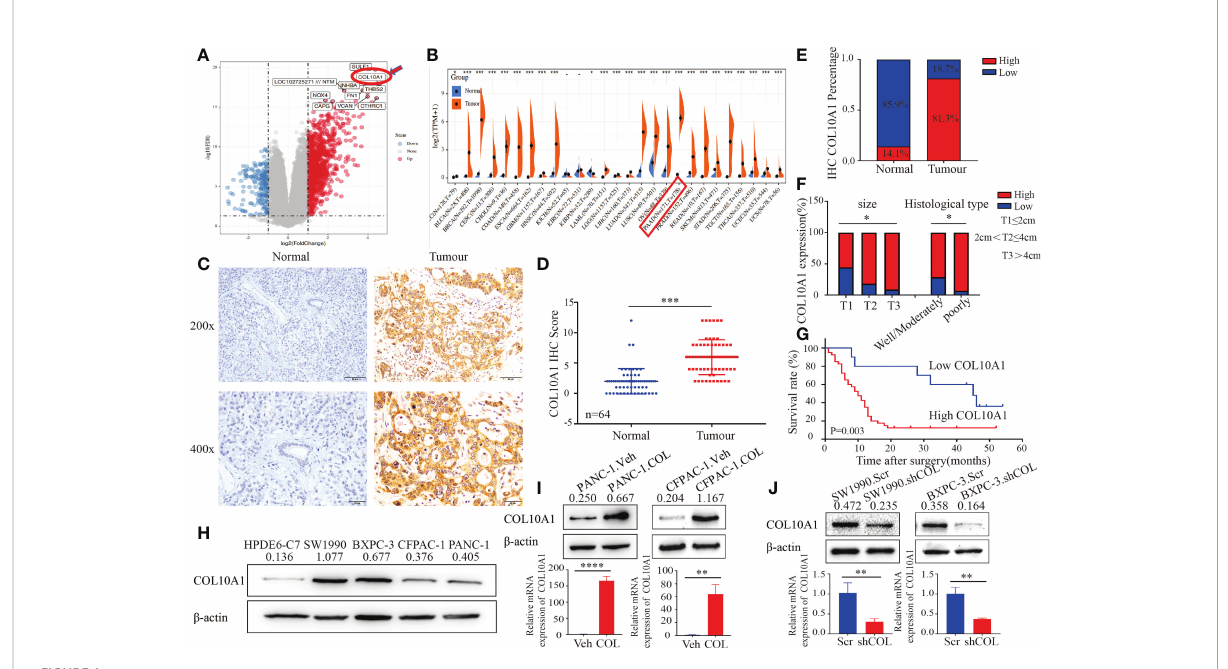
FIGURE 1 COL10A1 is up-regulated in PDAC and predicts poor prognosis. (A) GEO database (GSE15471) analysis to screen for genes that differ more signi fi cantly in pancreatic cancer versus normal tissue. (B) The GEPIA dataset showed that COL10A1 was highly expressed in a variety of tumors, and that COL10A1 expression was signi fi cantly higher in pancreatic cancer than in normal tissues. (C) IHC staining of COL10A1 in PDAC and normal pancreatic tissues. The scale bar at 200× magni fi cation represents 20 µm. The scale bar at 400× magni fi cation represents 50 µm. (D) COL10A1 IHC scores were differentially expressed between the normal and tumor groups. n = 64. Two-tailed Student ’ s t-test. (E) Percentage of COL10A1 IHC in PDAC and matched adjacent normal pancreatic tissues. n = 64. Chi-square test. (F) IHC staining analysis of COL10A1 expression in PDAC tissues with T classi fi cation and different differentiation characteristics. n = 64. Chi-square test. (G) Kaplan-Meier survival analysis of PDAC patients with high or low COL10A1 expression based on IHC data. (H) COL10A1 protein levels were detected in PDAC cell lines and one normal pancreatic ductal epithelial cell by western blot analysis. (I, J) COL10A1 expression was detected using western blot and RT- PCR by transfecting PDAC cell lines with COL10A1 shRNA and COL10A1-sense plasmids. * P < 0.05, ** P < 0.01, *** P < 0.001, **** P <